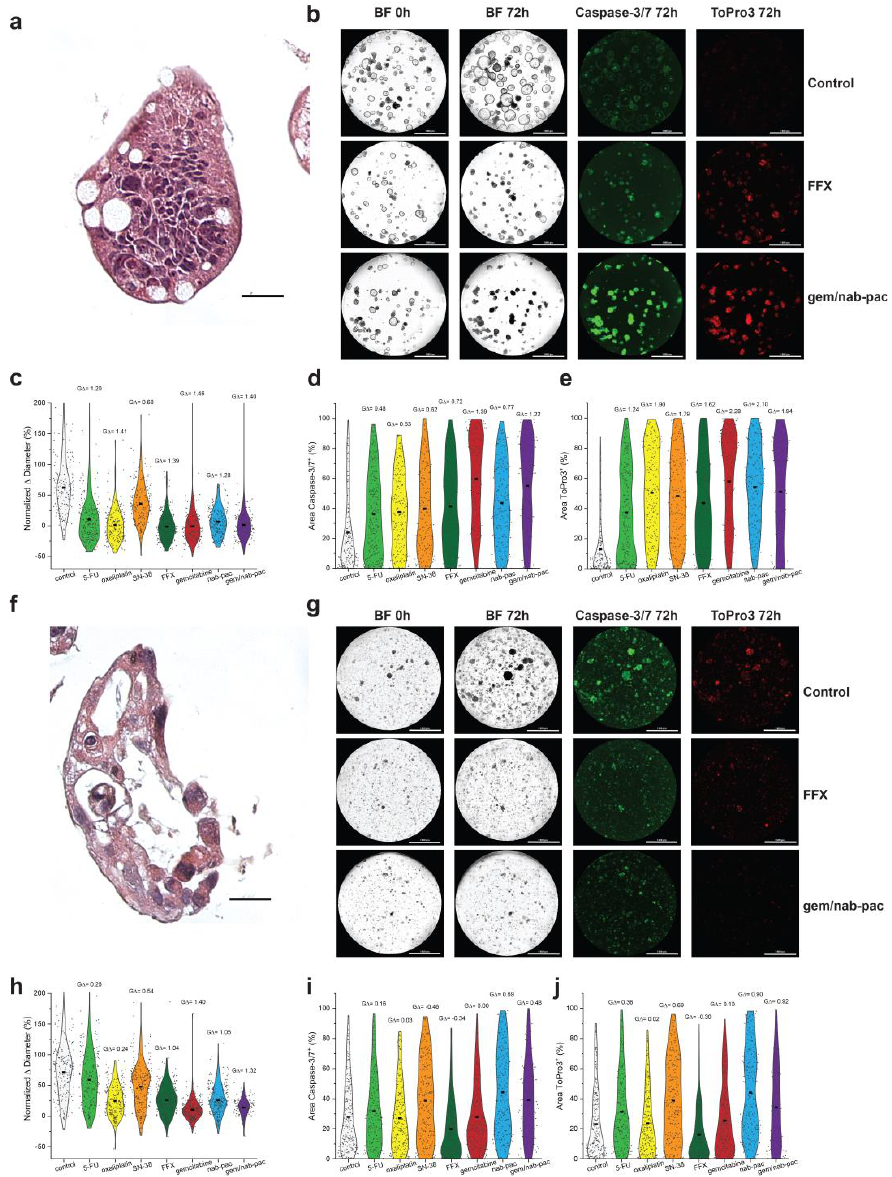
Figure 3. Therapeutic response assessment in organoids with a validated viability marker. ( a ) H&E staining of AMPC1, with corresponding nuclear atypia, ahigh nuclear to cytoplasmic ratio, and nu- clear atypia. ( b ) Images of AMPC1 organoids by treatment type, including media control (top row),